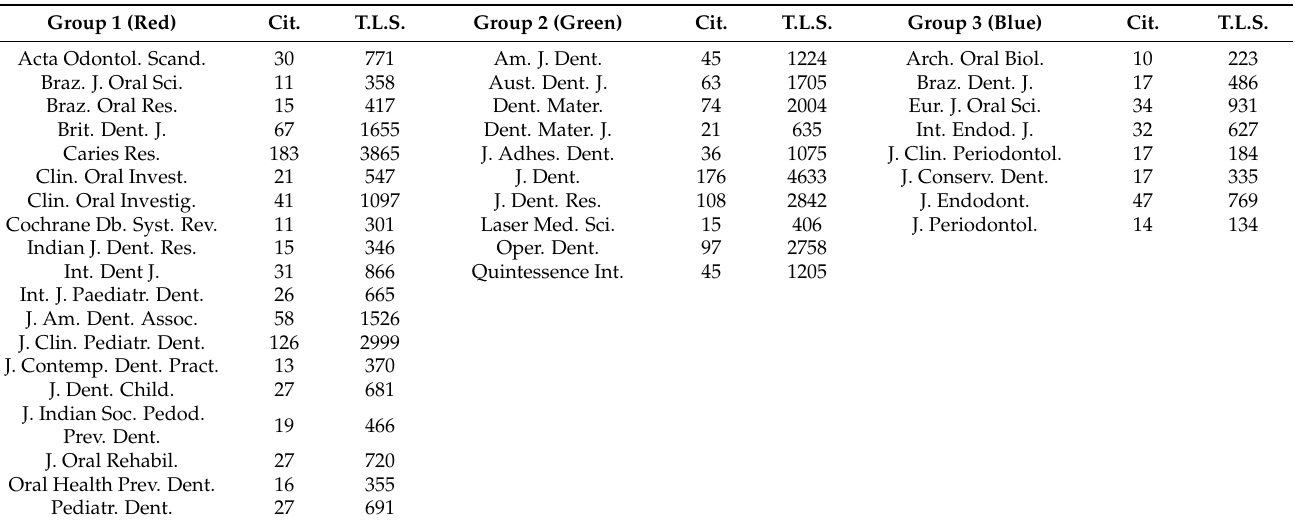
Table 5. Citation groups and related link strength in scientific journals. Source: own processing through